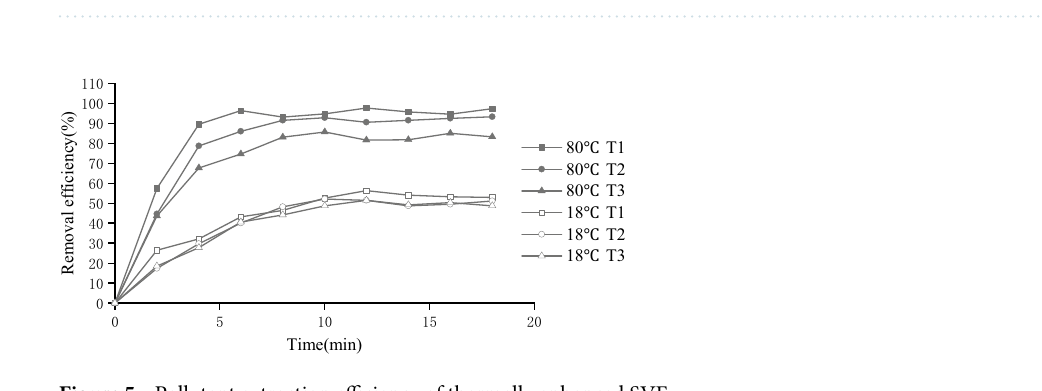
Figure 4. Extraction efficiency of different positions in the experimental device. ( a ) Distance from center of the extraction well, ( b ) Depth.